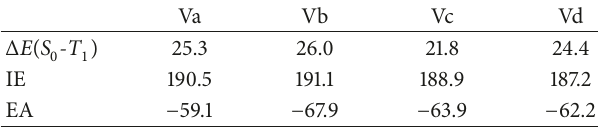
Table1: S 0 - T 1 energygaps( Δ E ( S 0 - T 1 ),inkcal mol −1 )andrespective SOC values (SOC, in cm −1 ), obtained with CASSCF(2,2)/LanL2DZ single point energy calculations on CAM-B3LYP/BS-1 structures.